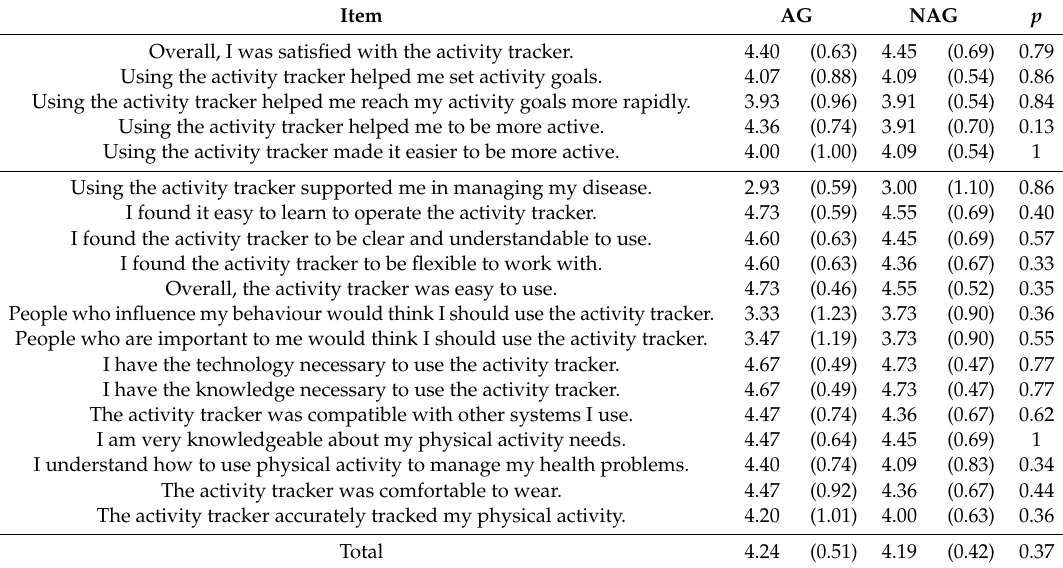
Table 4. Participant experience